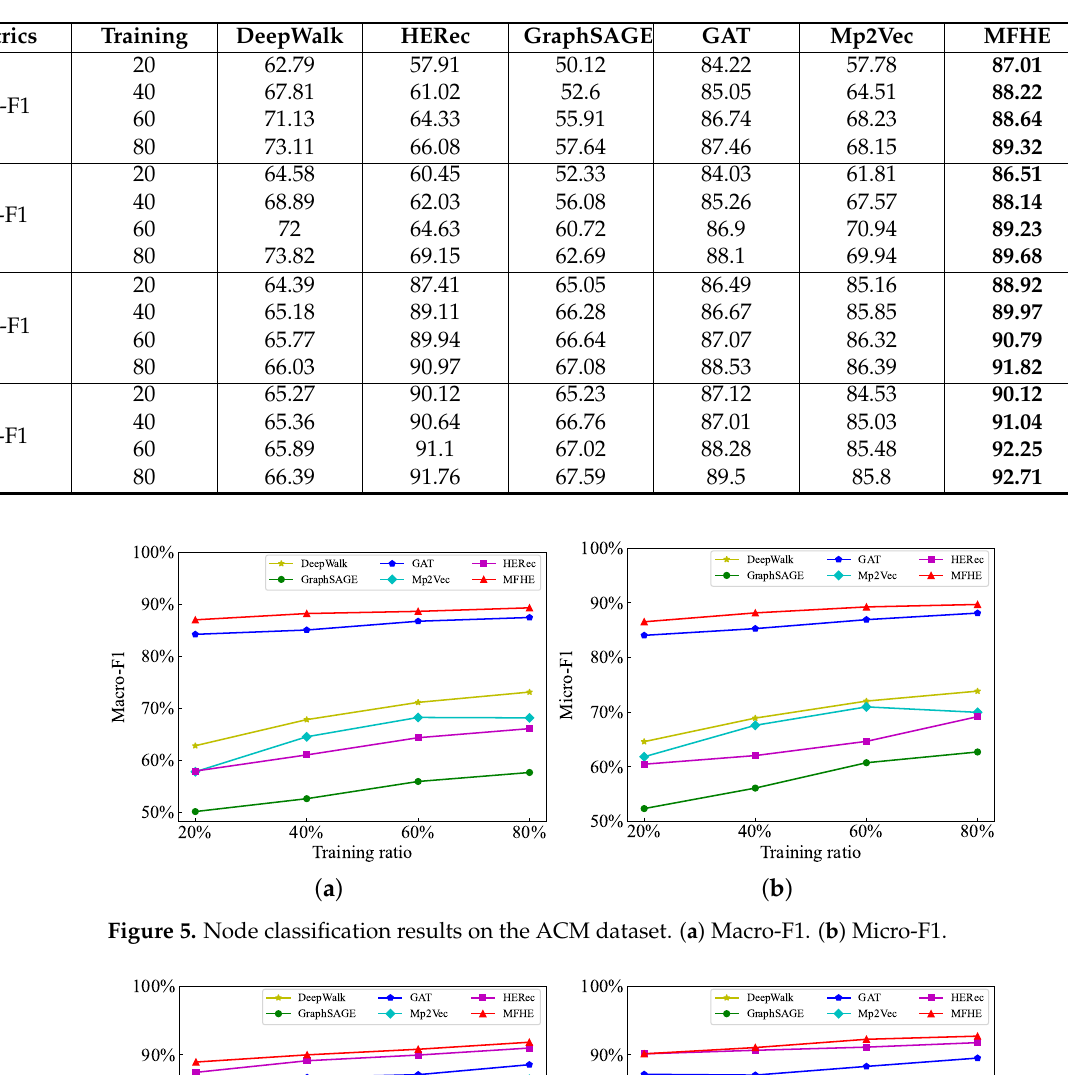
Table 4. Results of the node classification task (%).